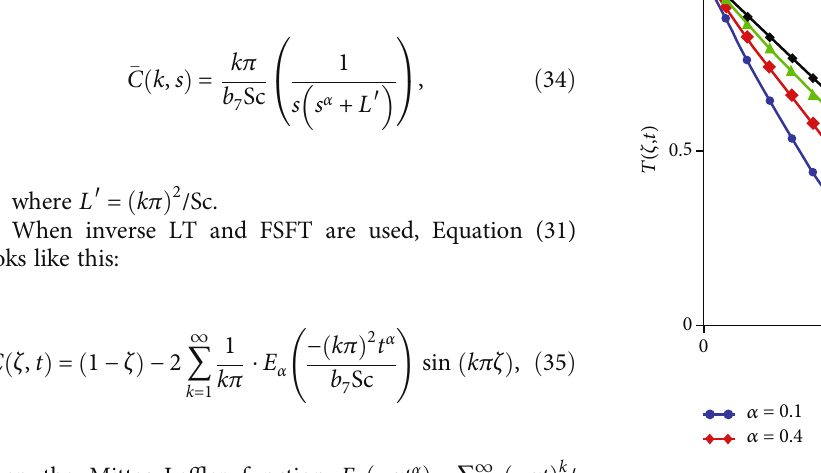
Figure 8: Impact of α on temperature